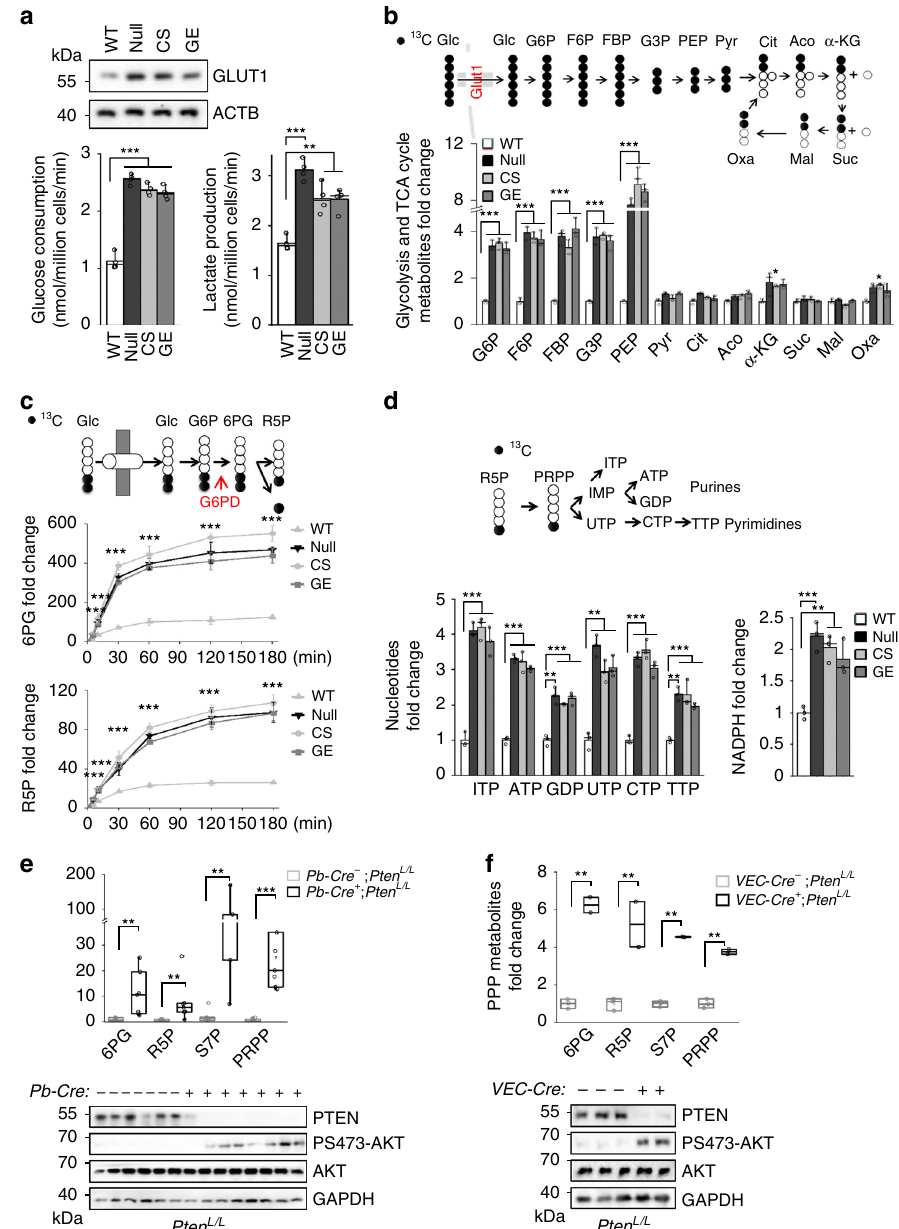
Fig. 1 PTEN loss or PI3K activation promotes glycolysis and PPP. a Loss of the PTEN lipid phosphatase activity increases the GLUT1 levels (upper panel), glucose consumption and lactate production in the Pten null, CS, and GE mES cells compared with the isogenic WT cells. b Upper panel, a schematic illustrating [U- 13 C] glucose metabolism; lower panel, loss of the PTEN lipid phosphatase activity increases the levels of 13 C-labeled glycolytic intermediates from G6P to PEP in the Pten null, CS, and GE mES cells compared with the isogenic WT cells. Glucose-6-phosphate (G6P), fructose-6-phosphate (F6P), fructose-1,6-bisphosphate (FBP), gyyceraldehyde-3-phosphate (G3P), phosphoenolpyruvate (PEP), pyruvate (Pyr), citrate (Cit), aconitate (Aco), α - ketoglutarate ( α -KG), succinate (Suc), malate (Mal), oxaloacetate (Oxa). c Upper panel, a schematic illustrating [1,2- 13 C] glucose tracing into the oxidative arm of the PPP; lower panel, faster and higher levels of labeled 6-phosphogluconate (6PG) and ribose-5-phosphate (R5P) in the Pten null, CS, and GE mES cells compared with the WT cells. d Upper panel, a schematic illustrating [1,2- 13 C] glucose tracing into the nucleotide biosynthesis pathway; lower panel, increased levels of labeled nucleotides and NADPH production in the Pten null, CS, and GE mES cells compared with the WT cells. e , f Upper panels, increased PPP metabolites in the Pten null prostate cancer and T-ALL mouse models. Metabolites in the PPP were extracted from the anterior lobes of the Pb-Cre − ;Pten L/L and Pb-Cre + ;Pten L/L mice ( e ) or the thymus of the VEC − Cre − ;Pten L/L and VEC − Cre + ;Pten L/L mice ( f ) by box plots. Median and quartile values are provided by the central line and box boundaries. Whiskers show min to max values. Sedoheptulose-7-phosphate (S7P), phosphoribosyl pyrophosphate (PRPP). n = 7 ( e ), n = 3 ( f ), numbers of independent mouse samples. a – d , cell extracts from Pten mutant cell lines were prepared and analyzed using LC-MS. Data are presented as fold changes and the mean ± SD and were compared with the WT cells. Each experiment was performed n = 4 ( a ) and n = 3 ( b – d ) independent times. * p < 0.05, ** p < 0.001, *** p < 0.001, based on Student ’ s t test (two-sided ANOVA). See also Supplementary Fig. 1. Source data are provided as a Source Data fi